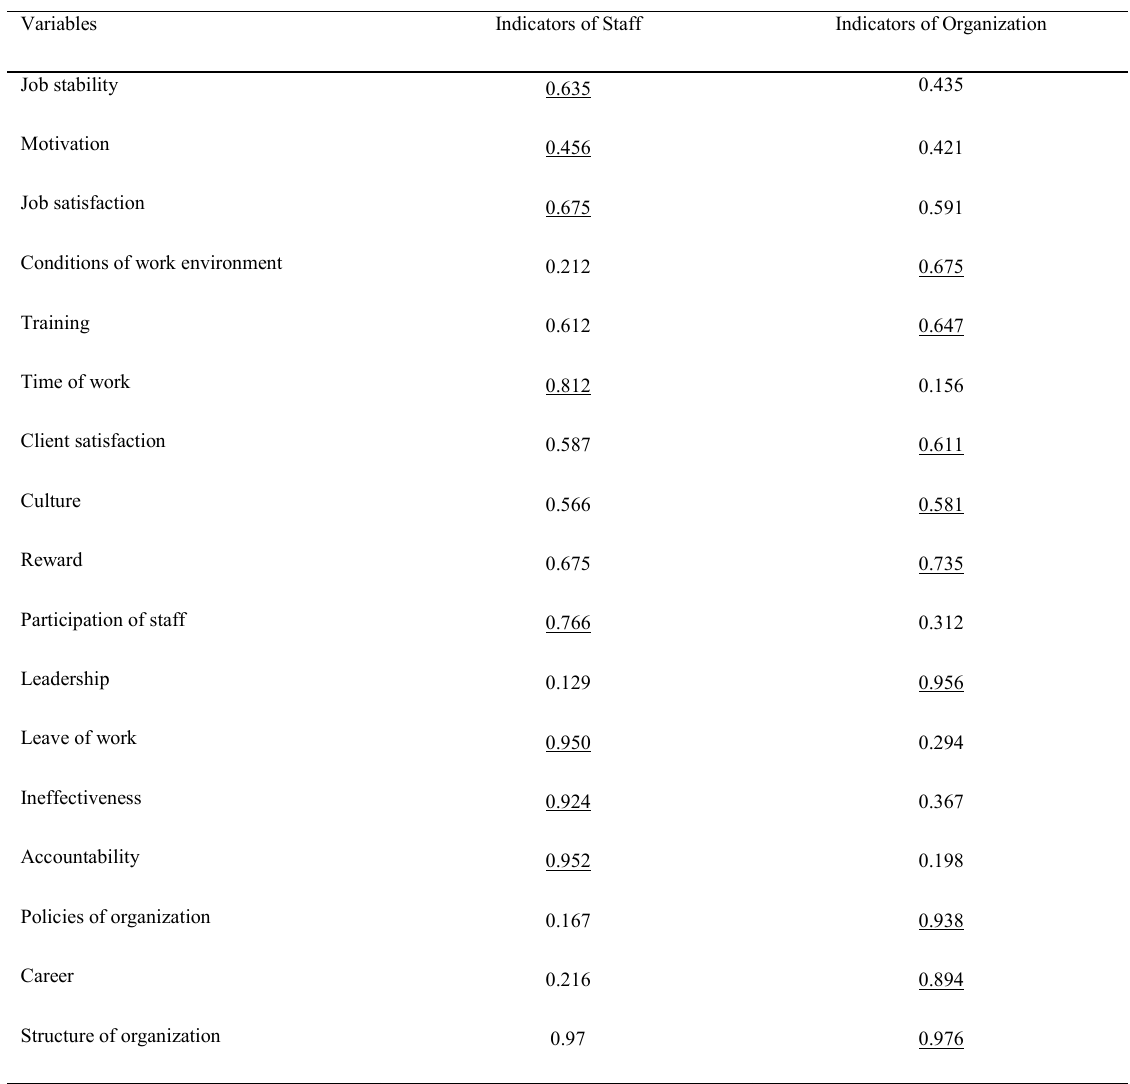
Table 2: Matrix of the